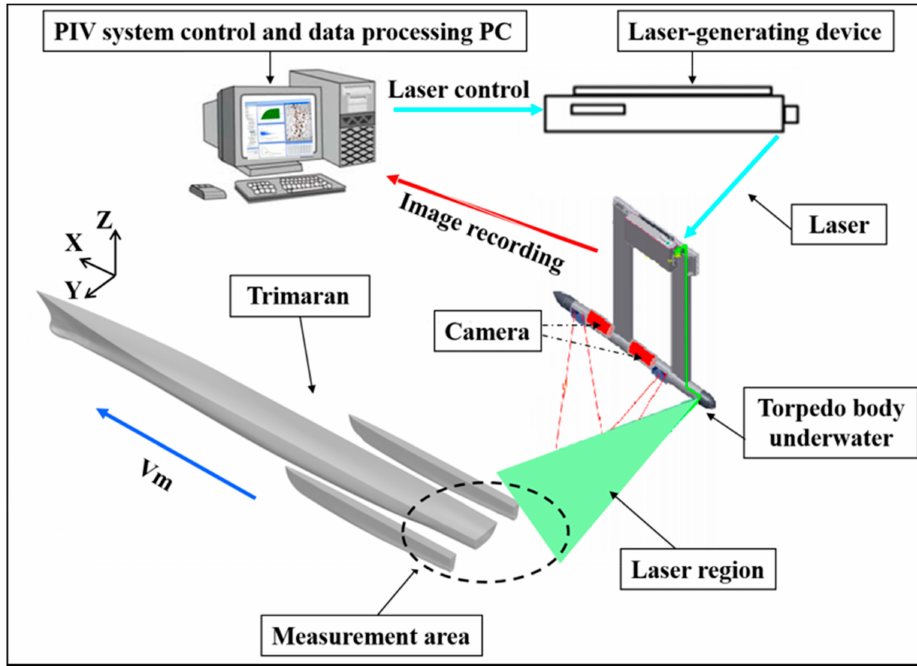
Figure 11. Arrangement of the measurement